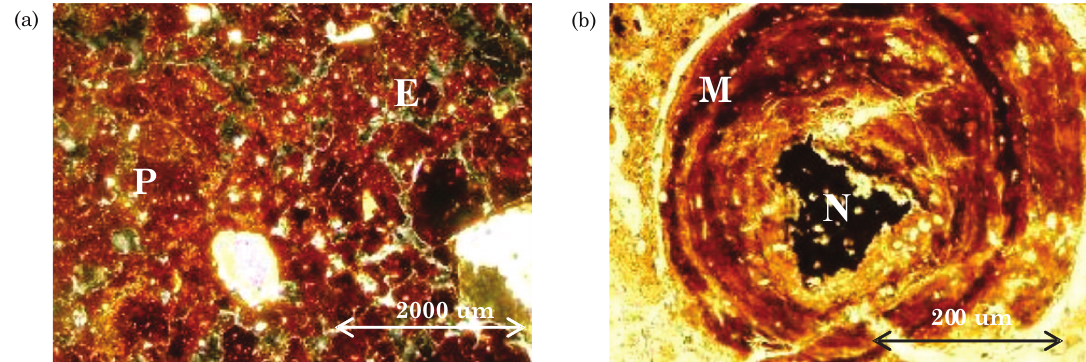
Figura 4. Fotomicrografias do horizonte Bi1 do P3. a) Distribuições relativas porfírica (P) e pórfiro-enáulica (E), vistas sob luz polarizada cruzada (XPL). b) Detalhe de nódulo de ferro concêntrico (N) separado da matriz por microfissura (M), observado sob luz polarizada plana